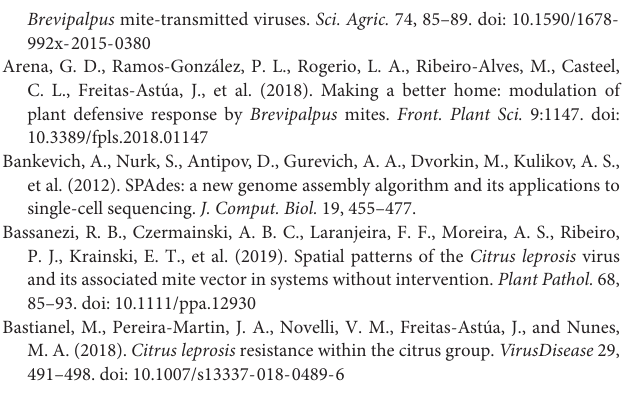
Supplementary Table 5 | Summary of selection analysis of the p29 and p32 in